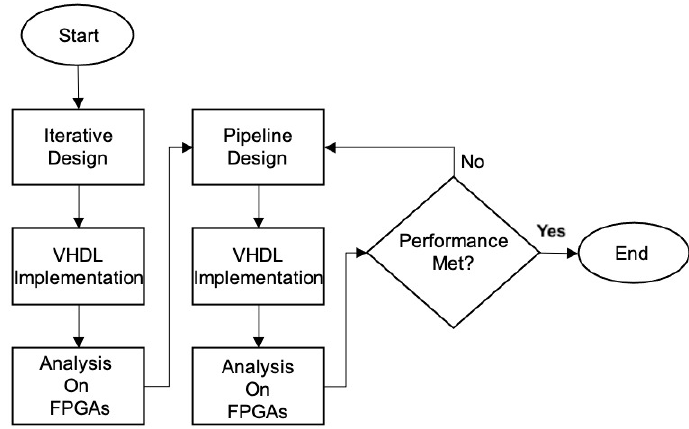
Figure 8. Methodology for developing and evaluating the hybrid hardware